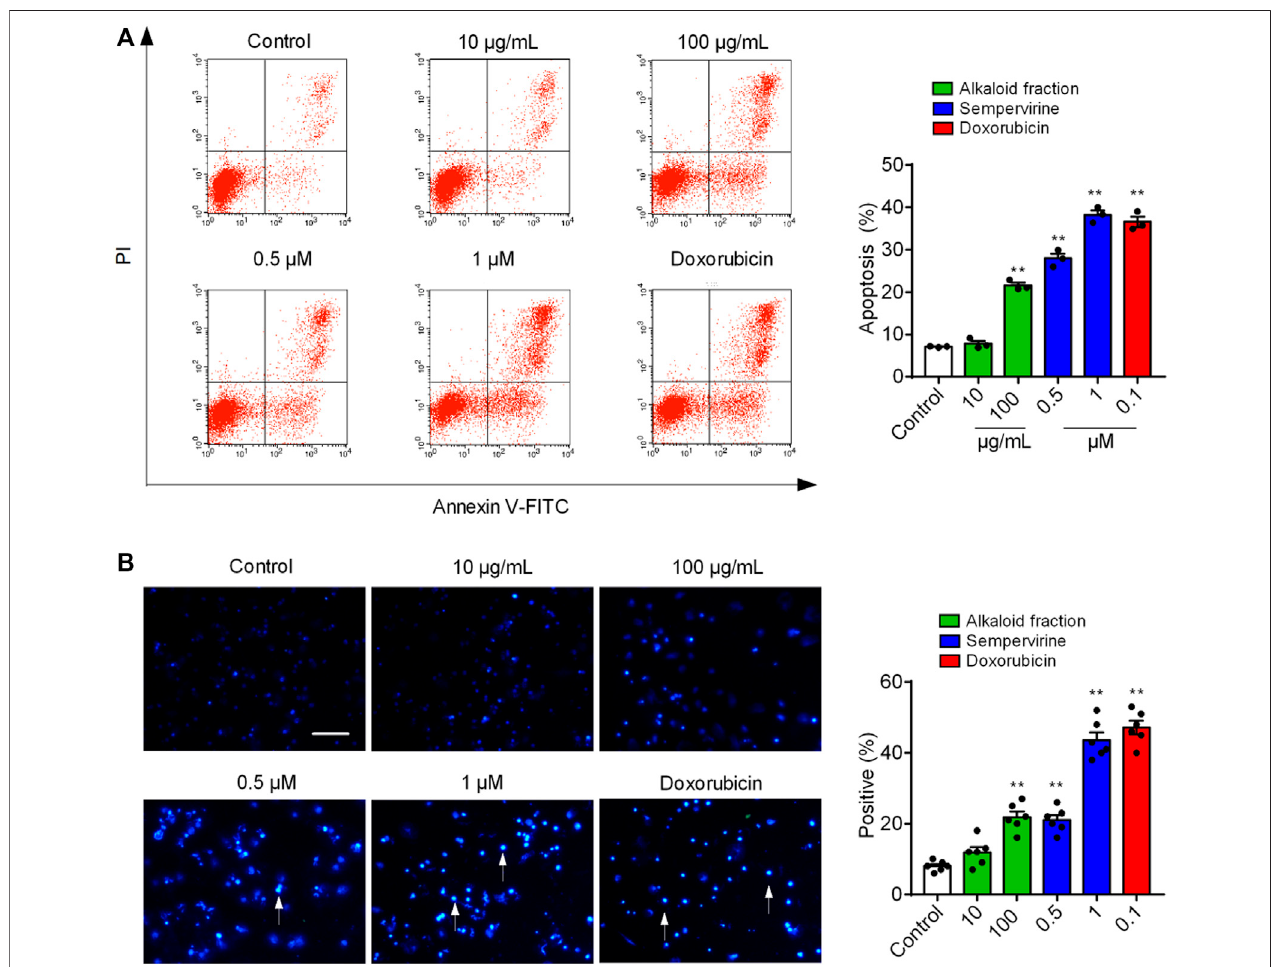
FIGURE3| SempervirineinducedapoptosisinHepG2cells. (A) Apoptosiswasevaluatedby fl owcytometry.The X- and Y -axesrepresentannexinV-FITCstaining and PI, respectively. (B) The morphological nuclear changes in HepG2 cells treated with sempervirine at different concentrations. The cells were stained with Hoechst 33258 for 30 min in the dark to examine the cleaved nuclei. ** p < 0.01 vs . Control.